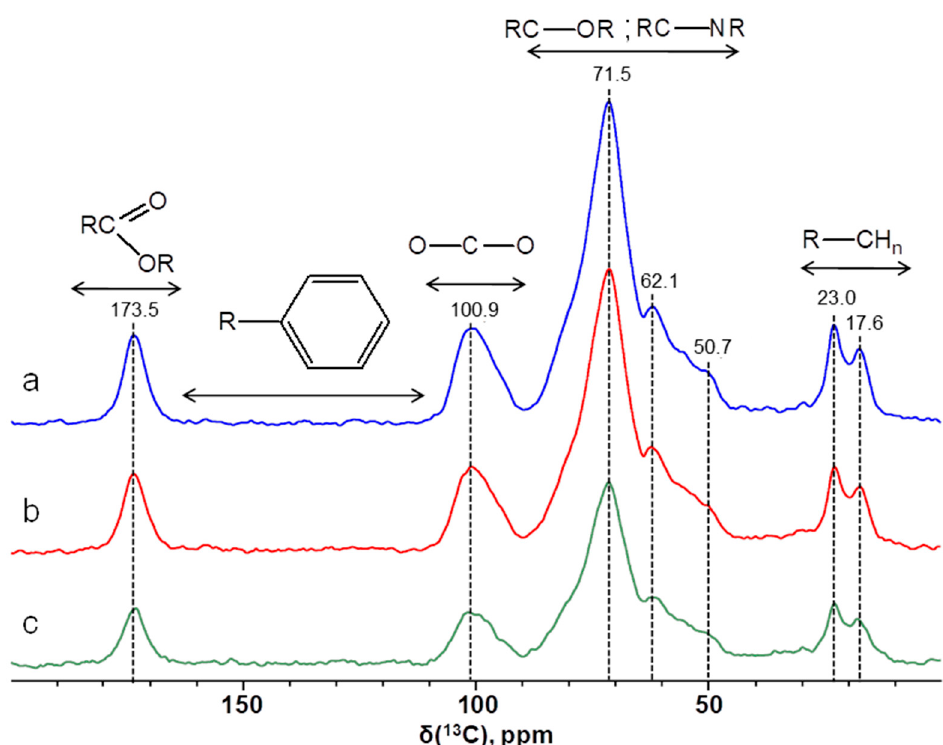
Figure 1. 13 C MAS NMR spectra of lyophilized HMWDOM extracted from a soil solution ( a ) Mw ≥ 14 kDa, ( b ) Mw ≥ 7 kDa, ( c ) Mw ≥ 3.5 kDa.